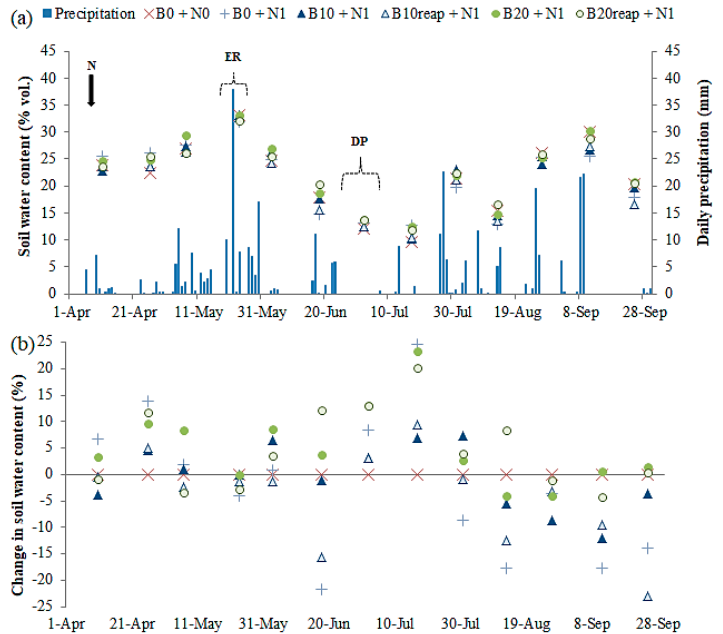
Figure 3. Soil water content dynamics in fertilized treatments N1 during the studied period in 2019: ( a ) soil water content with indication of daily precipitation, N—nitrogen fertilizer application, ER—extreme rainfall, DP—dry period; ( b ) percentage change in soil water content relative to control treatment B0 + N0 (without biochar and N-fertilizer application).